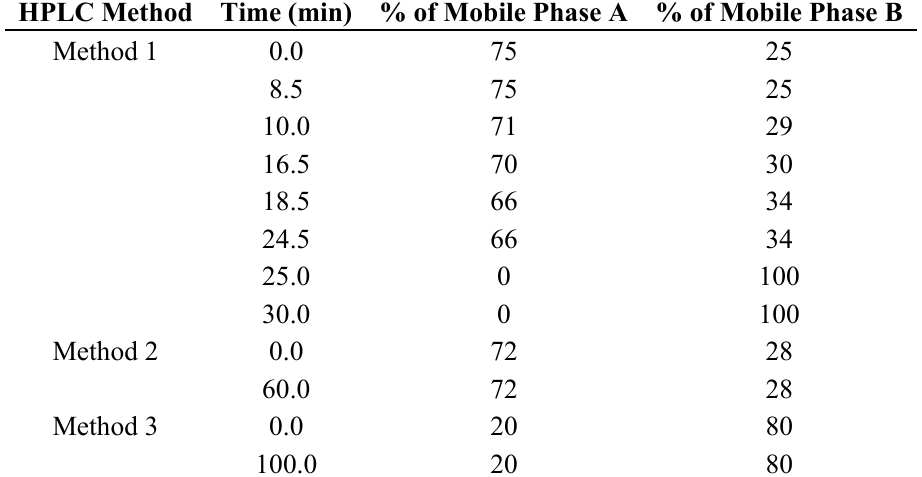
Table 3. RP-HPLC methods for the isolation and purification of steviol glycosides 1 – 4